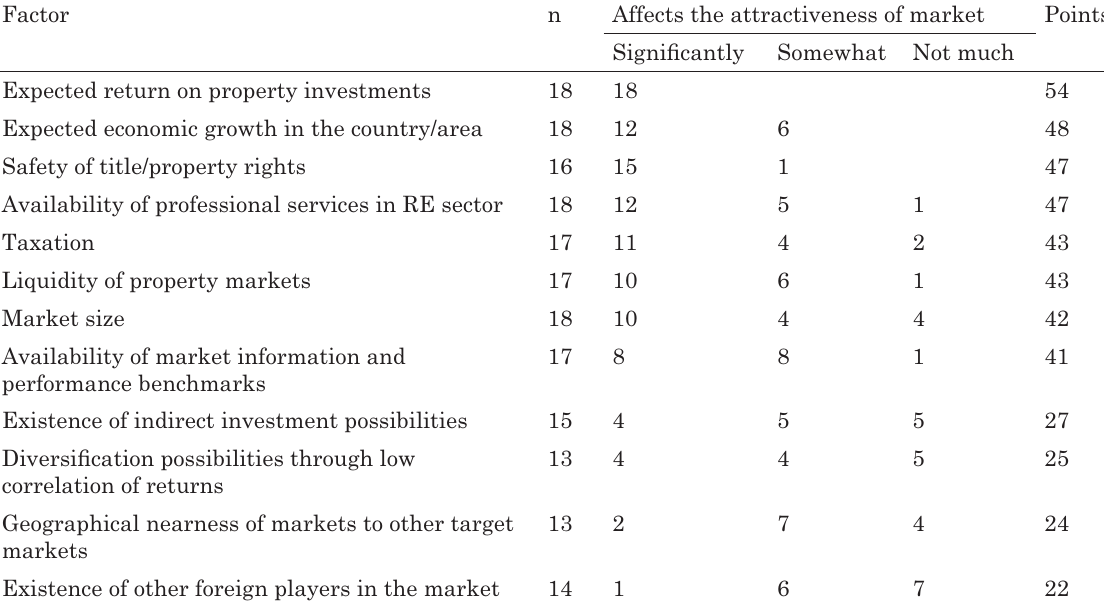
Table 9. Factors affecting the attractiveness of market Factor n Affects the attractiveness of